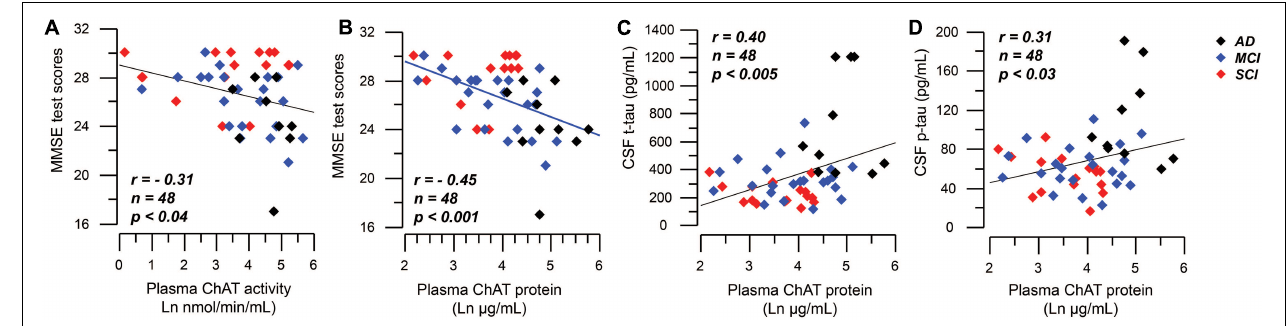
FIGURE 5 | Correlations between plasma ChAT levels and global cognition and CSF tau levels. (A) Illustrates a negative significant correlation between global cognitive performance as assessed by MMSE test and the activity of ChAT in plasma. Panel (B) shows the corresponding negative significant correlation between MMSE test scores and the plasma ChAT protein. Panels (C,D) show the positive correlations between the plasma ChAT protein and the t-tau (C) and p-tau (D) levels in CSF of all subjects. The plasma ChAT activity and protein levels are given in natural logarithm (Ln). AD = Alzheimer’s disease; ChAT = choline acetyltransferase; CSF = cerebrospinal fluid; MCI = mild cognitive impairment; p-tau = phosphorylated tau181 protein; SCI = subjective cognitive impairment; t-tau = total tau